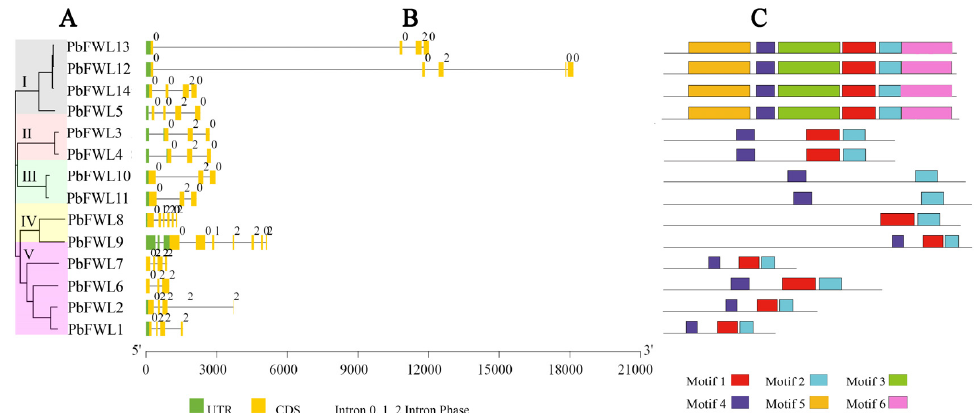
Figure 3. Gene structures of PbFWL genes, phylogenetic relationships, and conserved motifs of PbFWL proteins. ( A ) Phylogenetic tree of 14 PbFWL proteins in pear. The full-length amino acid sequences of 14 PbFWL proteins were imported into MEGA 7.0 software to construct an unrooted neighbor-joining phylogenetic tree. ( B ) Gene structure analysis of pear fw2.2-like members. The yellow boxes represent exons. The black lines represent introns. The green boxes represent UTR. The numbers 0, 1, and 2 represent the intron phases. ( C ) The conserved motifs in PbFWL proteins. The six predicted conserved structural domains are indicated by differently colored boxes. The motif information is shown in Supplementary Table S3.